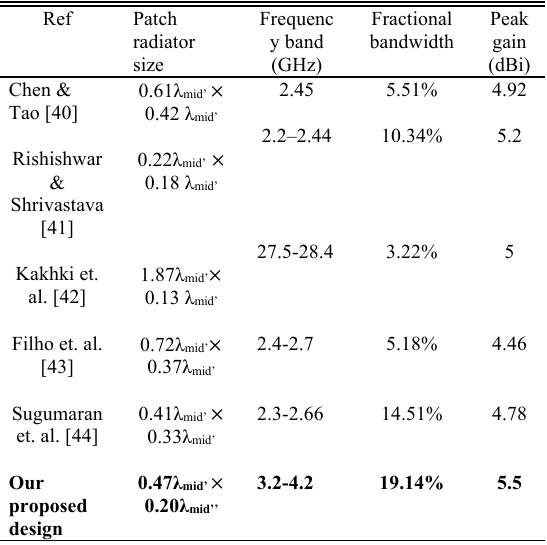
TABLE VII. Performance comparison with earlier investigated